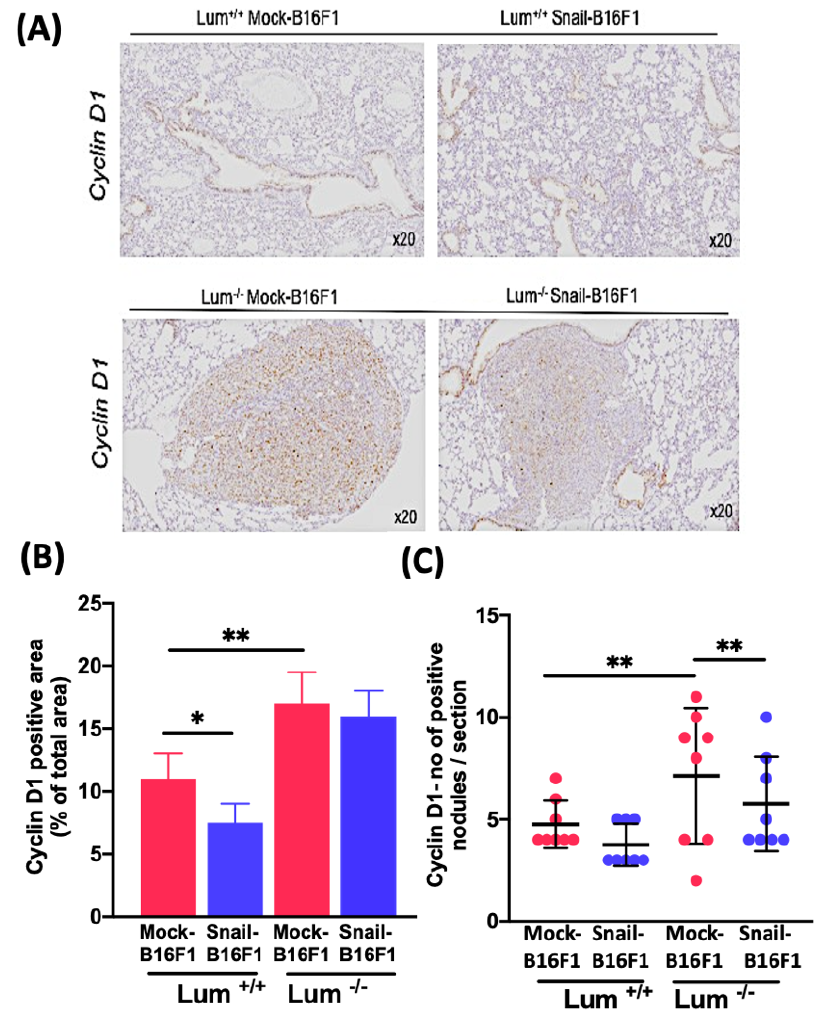
Figure 2. Evaluation of the expression of cyclin D1 in the Lum +/+ and Lum − / − C57BL/6J mice. ( A ) Immunohistochemistry of cyclin D1 in mice lungs of Lum +/+ and Lum − / − mice injected either with Mock-B16F1 or Snail-B16F1 melanoma cells. The immunostaining was localized to the cell nuclei. Hematoxylin counterstain; original magnification 20×. ( B ) Measurement of the cyclin D1 positive area (Cyclin D1 positive nuclei normalized to the total number of nuclei in lung nodules per lung section per mouse) in the Lum +/+ and Lum − / − group of mice, injected either with Mock-B16F1 or Snail-B16F1 cells. Cyclin D1 expression was found positive in both groups. ( C ) Measurement of the number of cyclin D1 positive nodules per section. Graphs represent the mean value ± standard deviation (n = eight mice per group, each symbol represents the value for every mouse) Statistical differences at the level of p < 0.05 and 0.01 are given with asterisks (*) and (**), respectively.